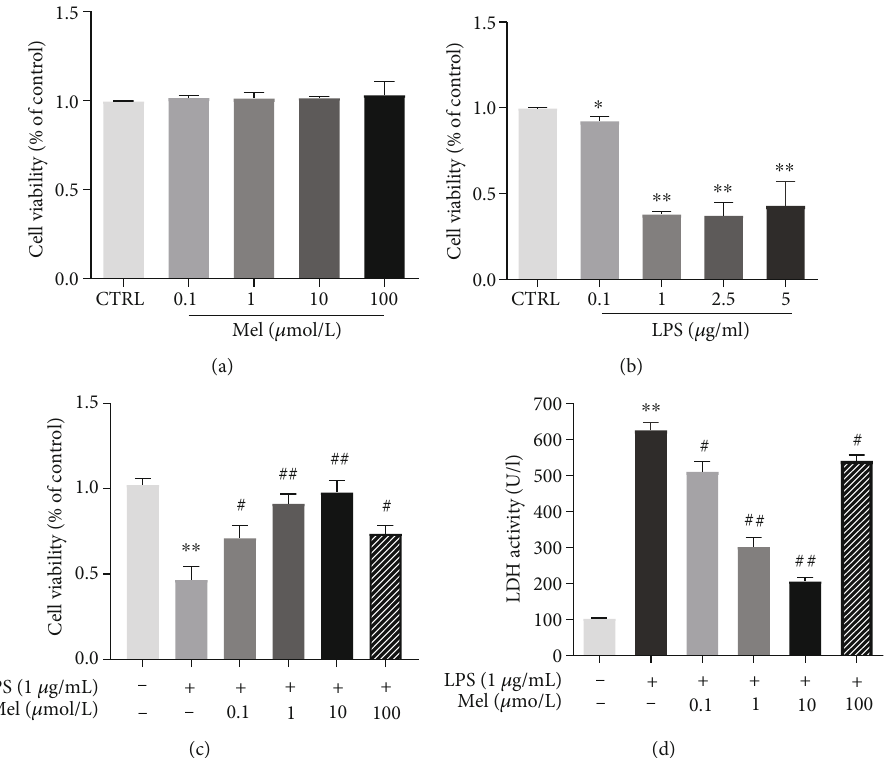
Figure 3: Melatonin improves cell viability in LPS-treated hiPSC-CMs. (a) hiPSC-CMs were challenged with various doses of melatonin (0.1, 1, 10, and 100 μ mol/l) for 12 h; the viability of hiPSC-CMs was measured by CCK-8 assay. (b) hiPSC-CMs were treated with various doses of LPS (0.1, 1, 2.5, or 5 μ g/ml) for 24h. (c) hiPSC-CMs were incubated with LPS (1 μ g/ml) for 24 h post melatonin pretreatment (0.1, 1, 10, or 100 μ mol/l) for 12h; then, the cell viability of hiPSC-CMs was assessed by CCK-8 assay. (d) Measurement of LDH release level in the same condition of (c). n ≥ 3 ; ∗ P < 0 : 05 vs. control; ∗∗ P < 0 : 01 vs. control; # P < 0 : 05 vs. LPS; ## P < 0 : 01 vs.